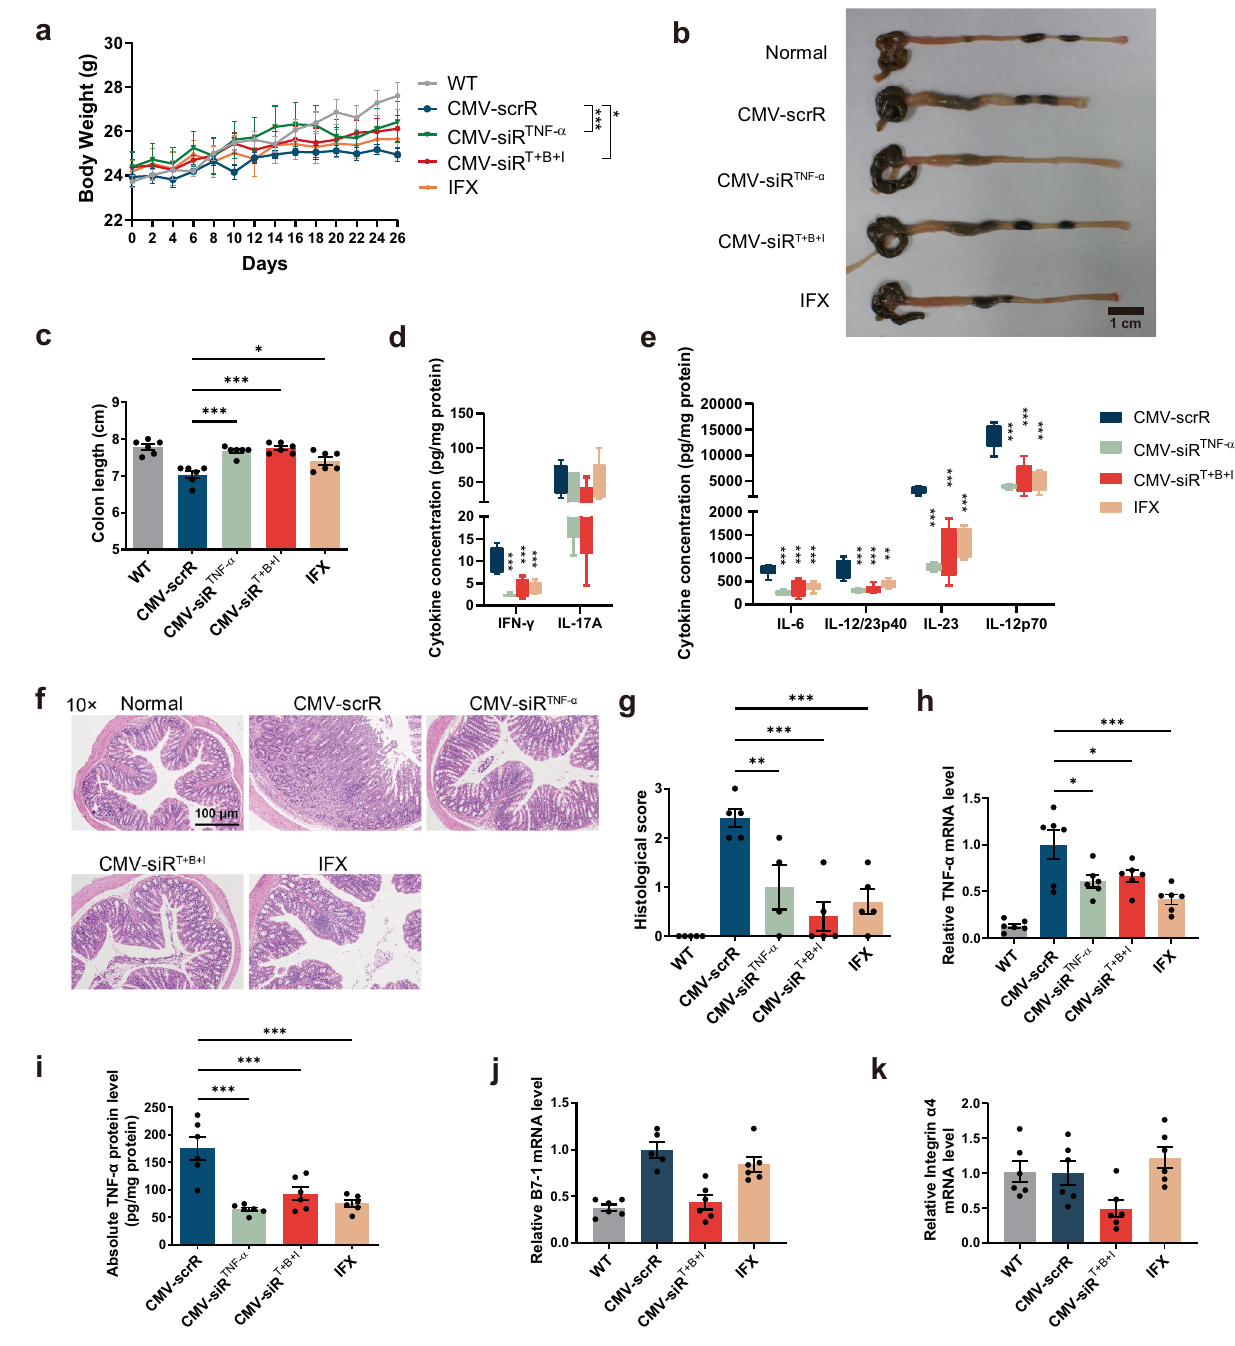
Fig. 9 | Intravenous injection of the CMV-siR TNF- α or CMV-siR T+B+I circuit ame- liorates spontaneous UC in IL-10 − / − mice. a Body weight curves ( n =6 in each group). b Representative macroscopic features of colons. Scale bar: 1cm. c Mean colon length ( n =6 ineachgroup). d , e Determination ofthe levelsof IFN- γ , IL-17A, IL-6, IL-12/23p40, IL-23 and IL-12p70 in the colon by ELISA ( n =6 in each group). f Representative images of H&E staining of colon sections. Scale bar: 200 μ m. g Histologicalscoresofcolonsections( n =5inWT,CMV-scrR,CMV-siR T+B+I